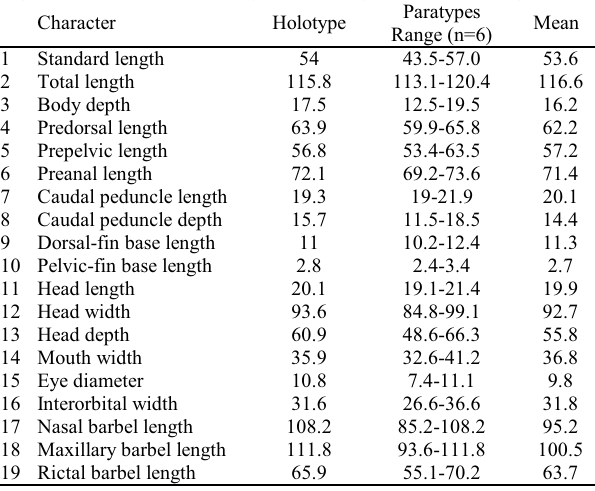
Table 1. Morphometric data of Trichomycterus uisae. Stan- dard length is expressed in millimeters. Measurements 2 to 11 are expressed as percents of standard length, measurements 12 to 19 are expressed as percents of head